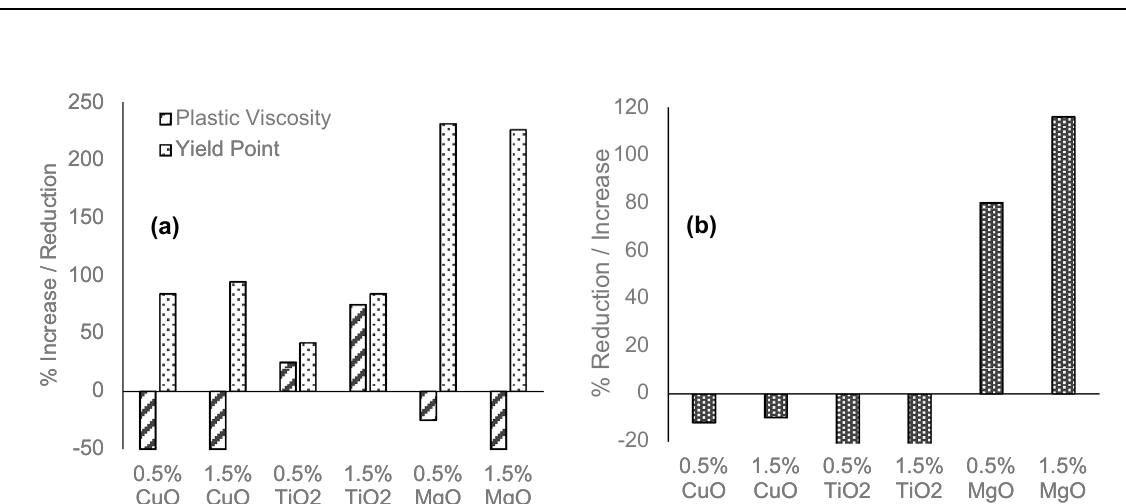
Fig. 10 Effect of nanoparticles on a plastic viscosity and yield point, and b fluid